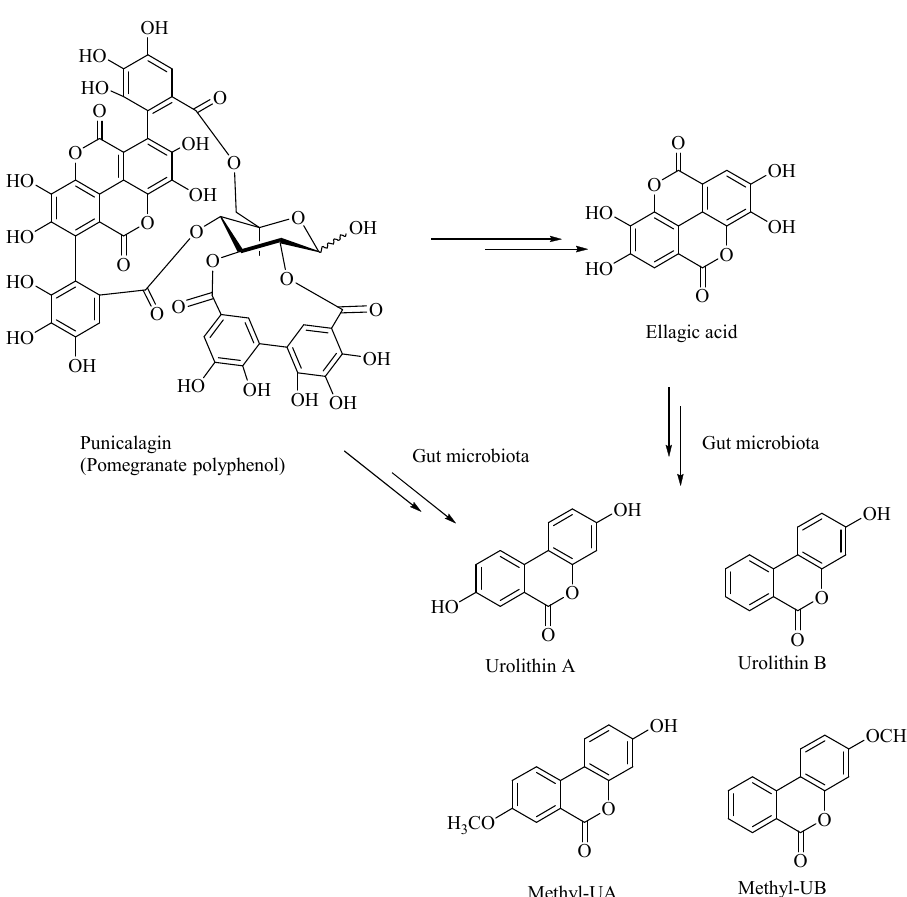
Figure 6. Gut bacterial metabolites of punicalagin, a pomegranate derived polyphenol. Chlorogenic acid-derived catabolites, such as dihydrocaffeic acid, dihydroferulic acid and